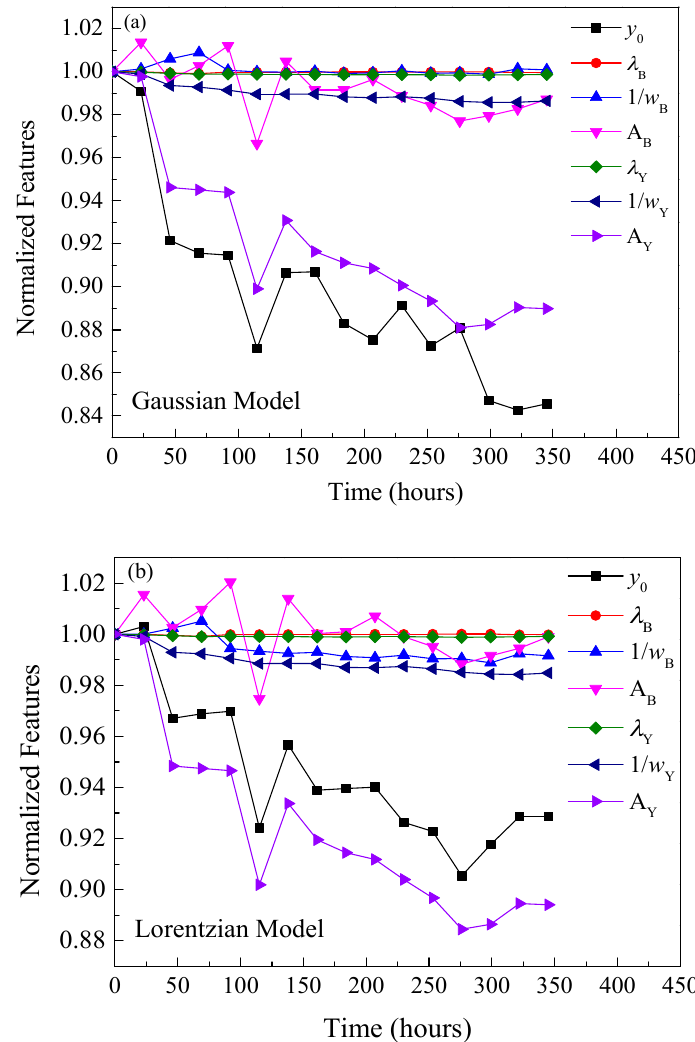
Figure 10. Shift trajectories of normalized features extracted from SPDs by ( a ) Gaussian model and ( b ) Lorentzian model until 345 h.